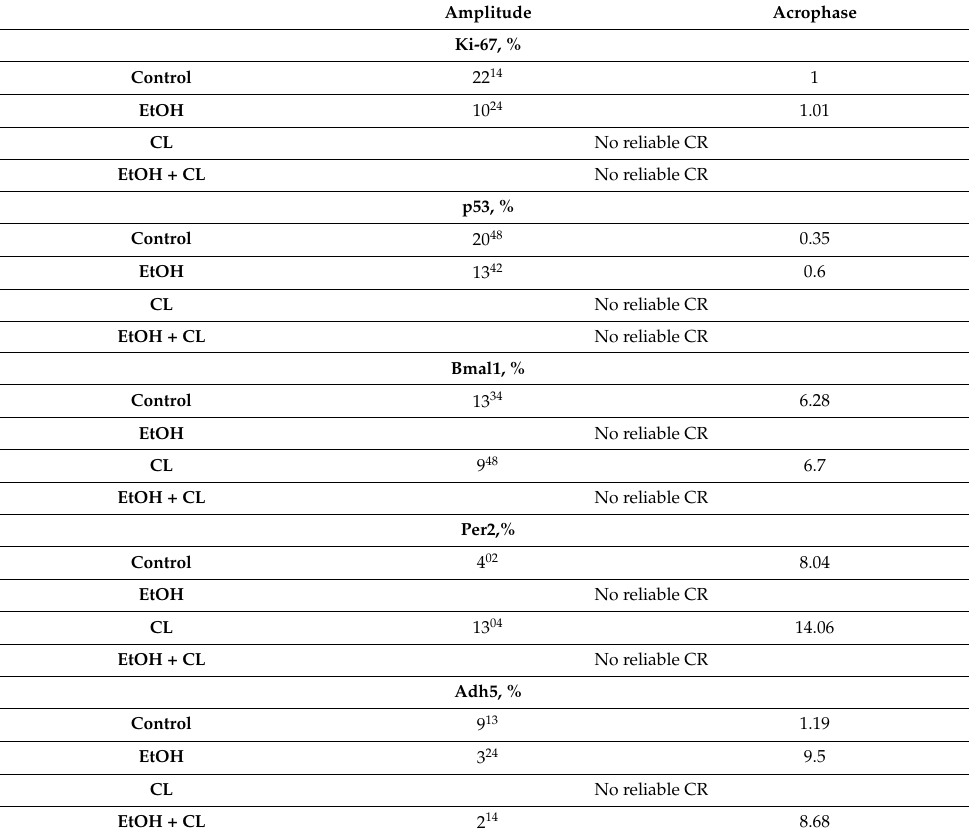
Table 5. Cosinor analysis of biochemical parameters in the livers of rats.